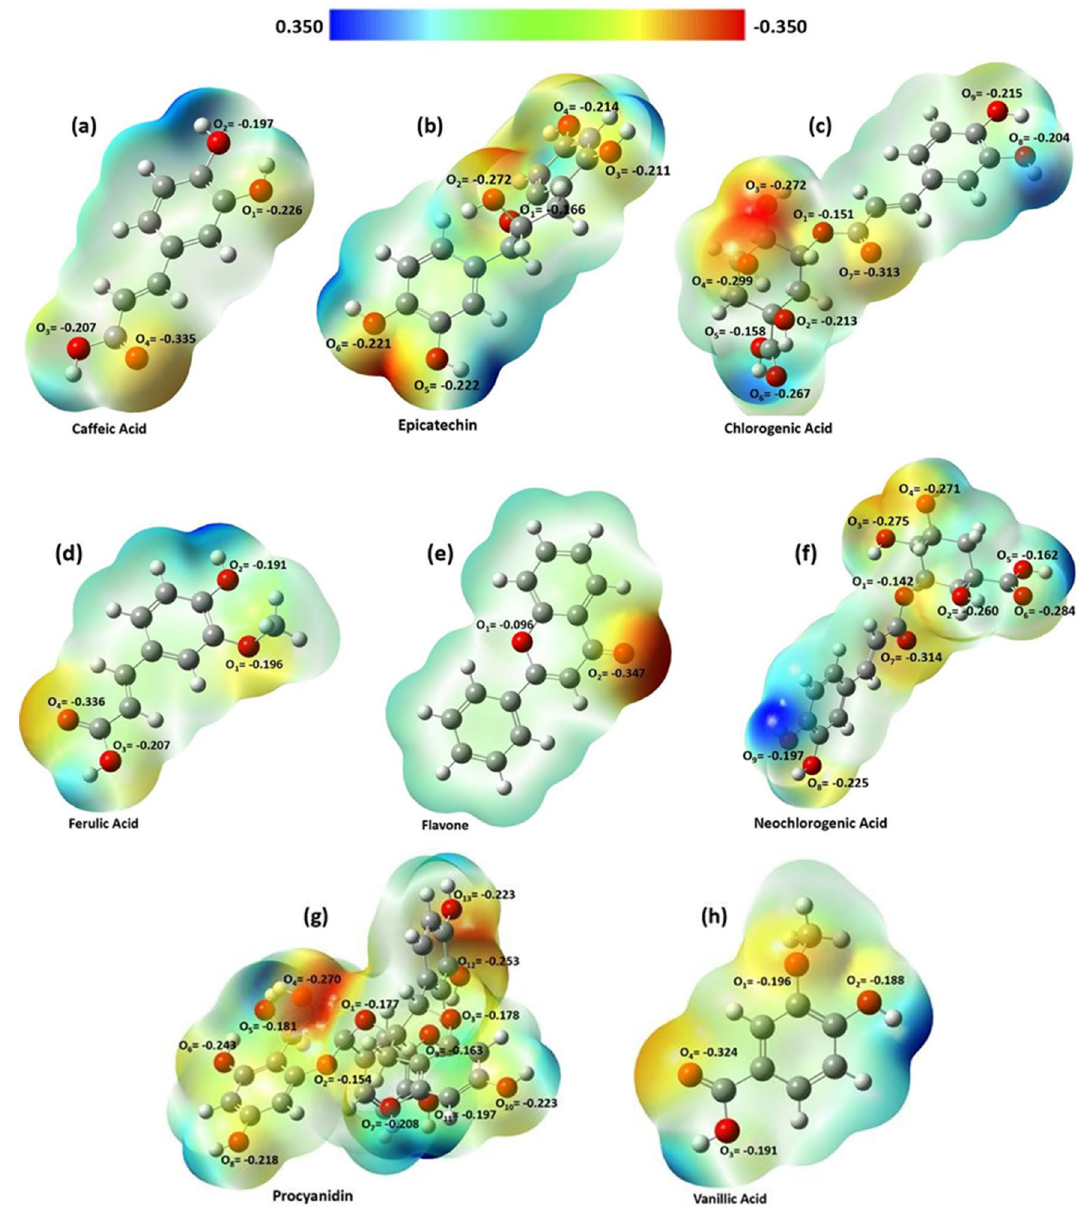
Figure 9. Charge distribution (Hirshfeld point charges) of eight phytoactive compounds and their electrostatic potential map for ( a ) Caffeic acid, ( b ) Epicatechin, ( c ) Chlorogenic acid, ( d ) Ferulic acid, ( e ) Flavone, ( f ) Neochlorogenic acid, ( g ) Procyanidin, and ( h ) Vanillic acid. The scale bar at the top of this figure demonstrates regions of electron excess (reddish area) to regions of electron deficiency (bluish area). The geometry optimization of active compounds was carried out at the B3LYP/6-311++g(d,p) level of graphs in Fig. 8 corroborate the discussion on logS values, which indicate that vanillic acid is considerably more hydrophilic (meaning more tendency to interact with water than nanoparticle) than chlorogenic acid, neochlo- rogenic acid, caffeic acid, ferulic acid, epicatechin, procyanidin, and flavone, respectively. As a preliminary pre-conclusion, one could mention the followings: (i) while the phenolic compound fla-